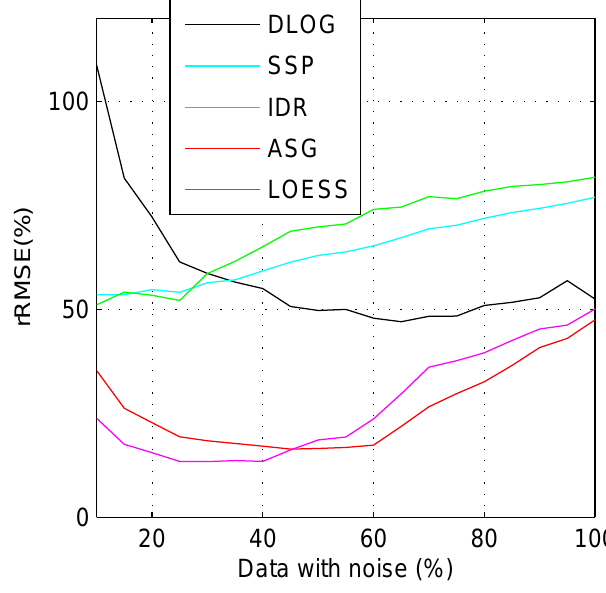
Figure 5. Performance of the applied filtering methods in terms of rRMSE averaged over the nine